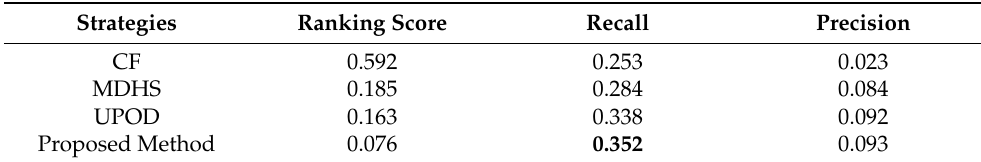
Table 5. µ comparison with other methods [23–27,32,33].